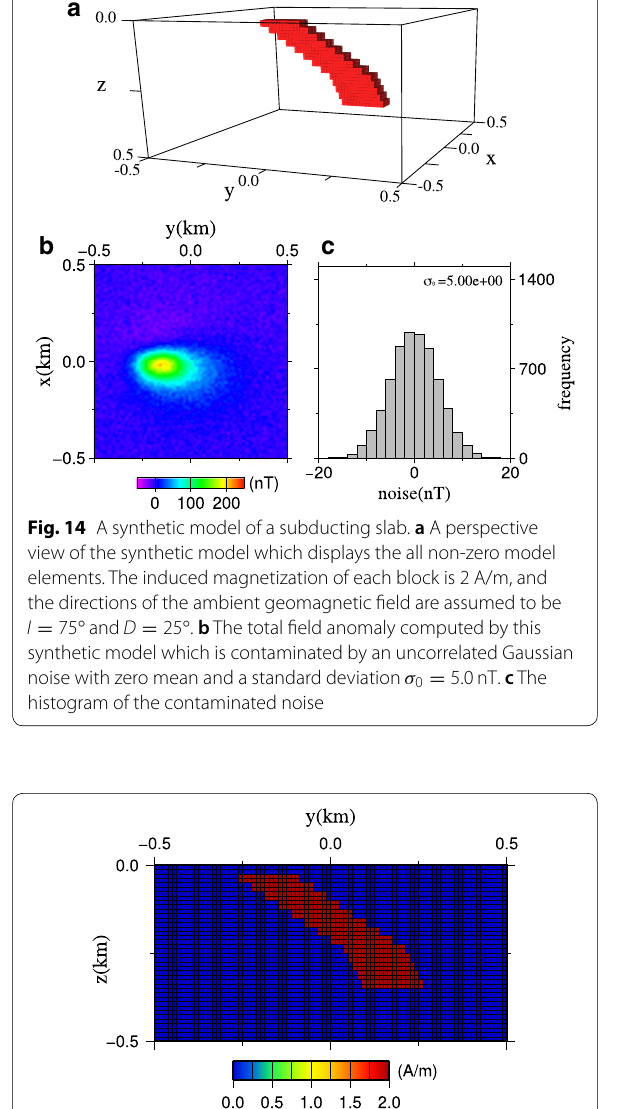
Fig. 15 A cross-section of the synthetic model. A cross-section of the synthetic model of Fig. 14 through the x